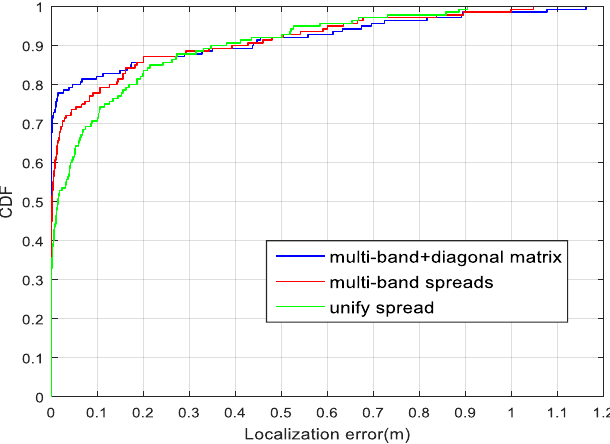
Figure 12. Cumulative distribution functions of localization errors for different spread modes.